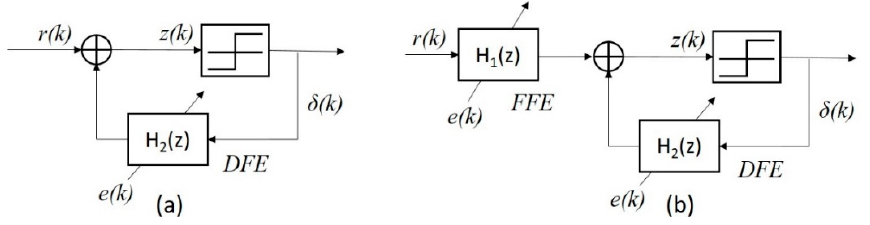
Figure 8. The structure of ( a ) DFE; ( b ) FFE and DFE combined.